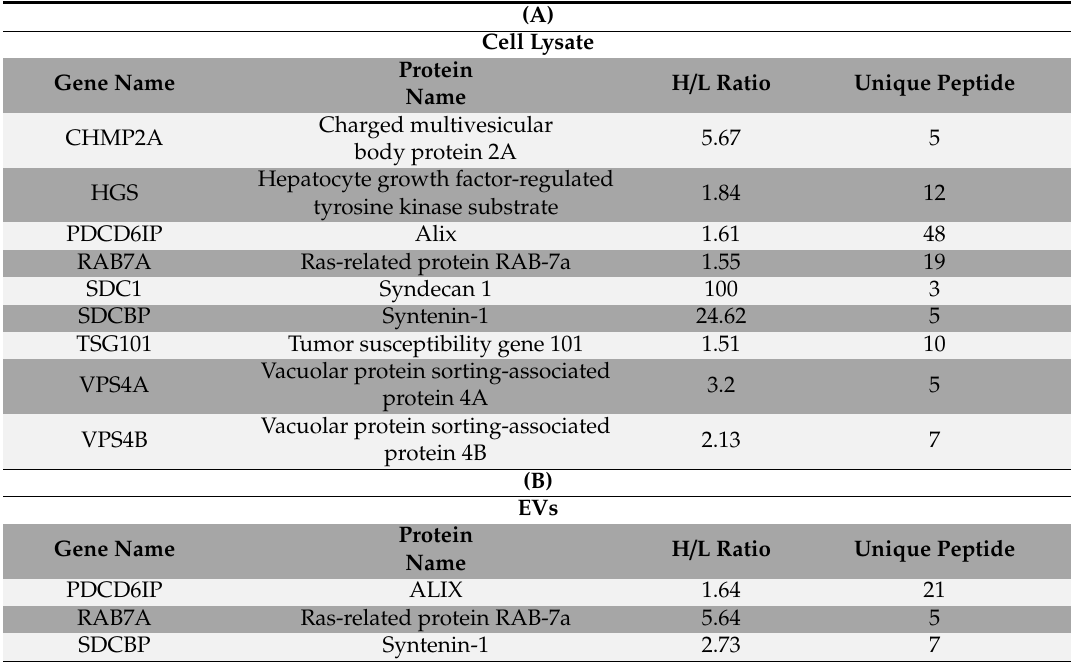
Table 1. Gene ontology analysis identified newly synthesized cell lysate ( A ) and EVs ( B ) proteins that belong to the GO:1903543~positive regulation of exosomal secretion biological process.